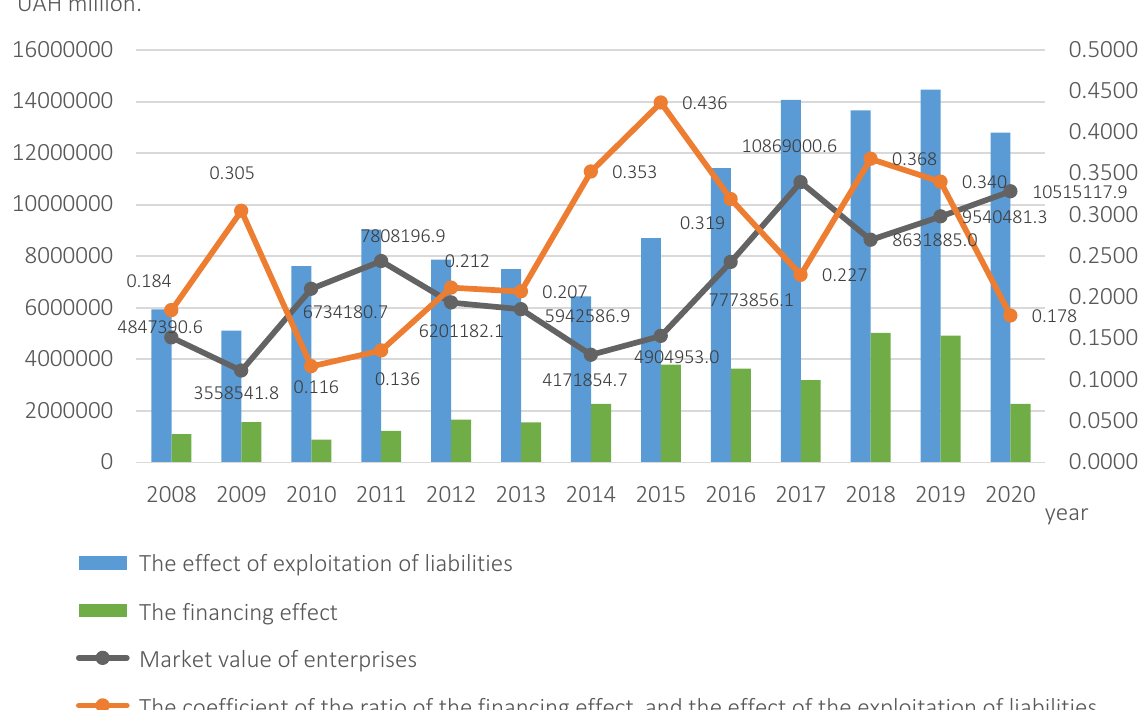
Figure 3. Indicators of formation of the industrial enterprises’ market value in Ukraine in